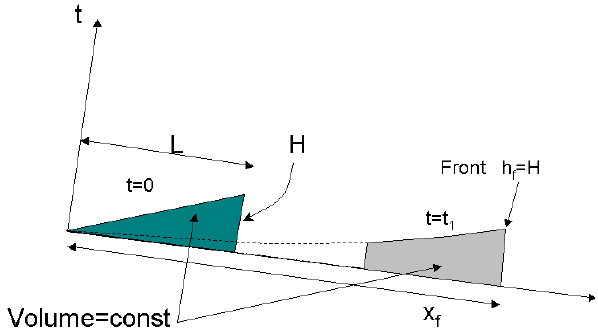
Fig. 2. Scheme of kinematic wave, as proposed by Eqs.